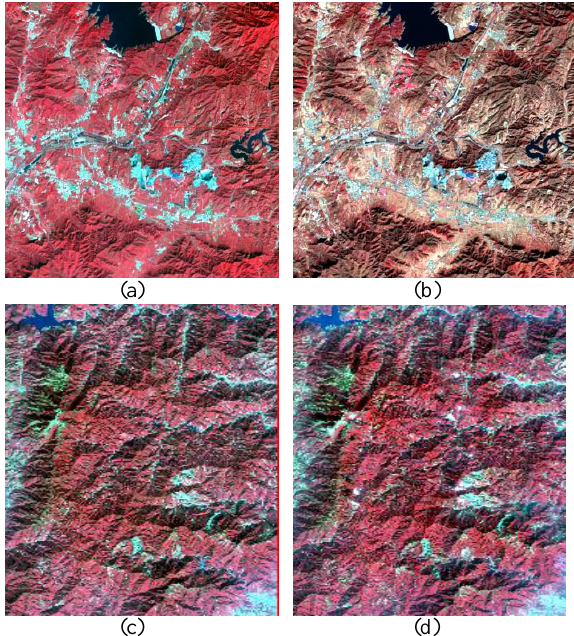
Figure 1. Experimental data. (a) is Landsat-8 data acquired in 20131003 ,(b) is Landsat-8 data acquired in 20131104, (c) is GF-1 data acquired in 20131205, (d) is GF-1 data acquired in